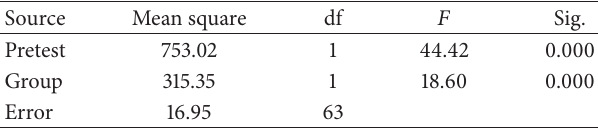
Table 2: Analysis of covariance on posttest of the Iranian female adolescents’ self-esteem as dependent